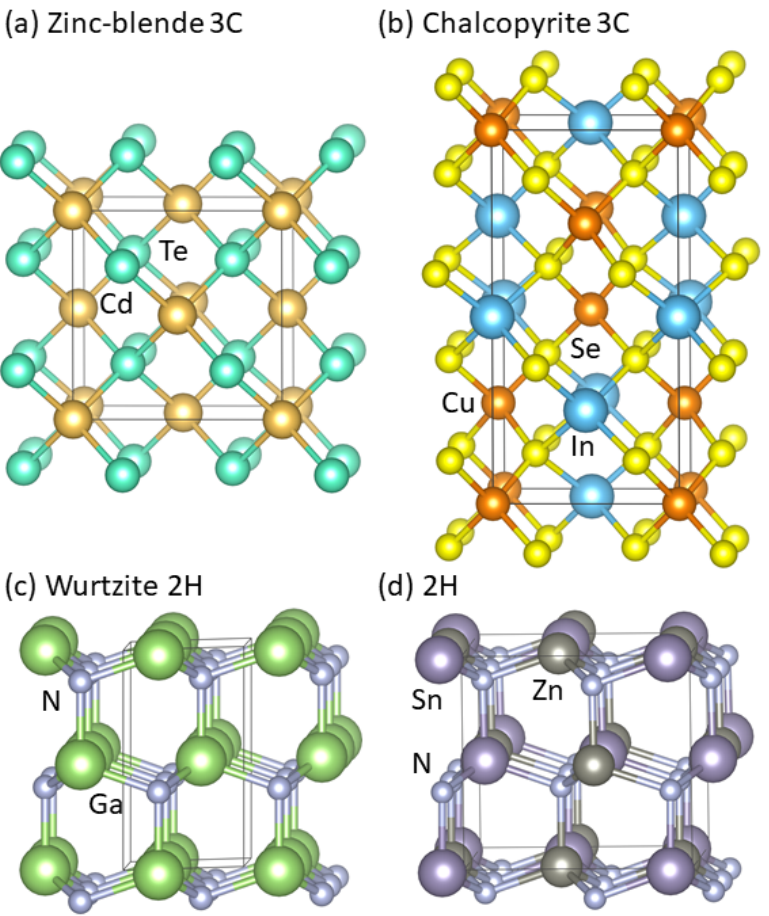
Figure 1. Atomic structure of ( a ) zinc-blende CdTe, ( b ) chalcopyrite CuInSe 2 , ( c ) wurtzite GaN, and ( d ) ZnSnN 2 . (Color